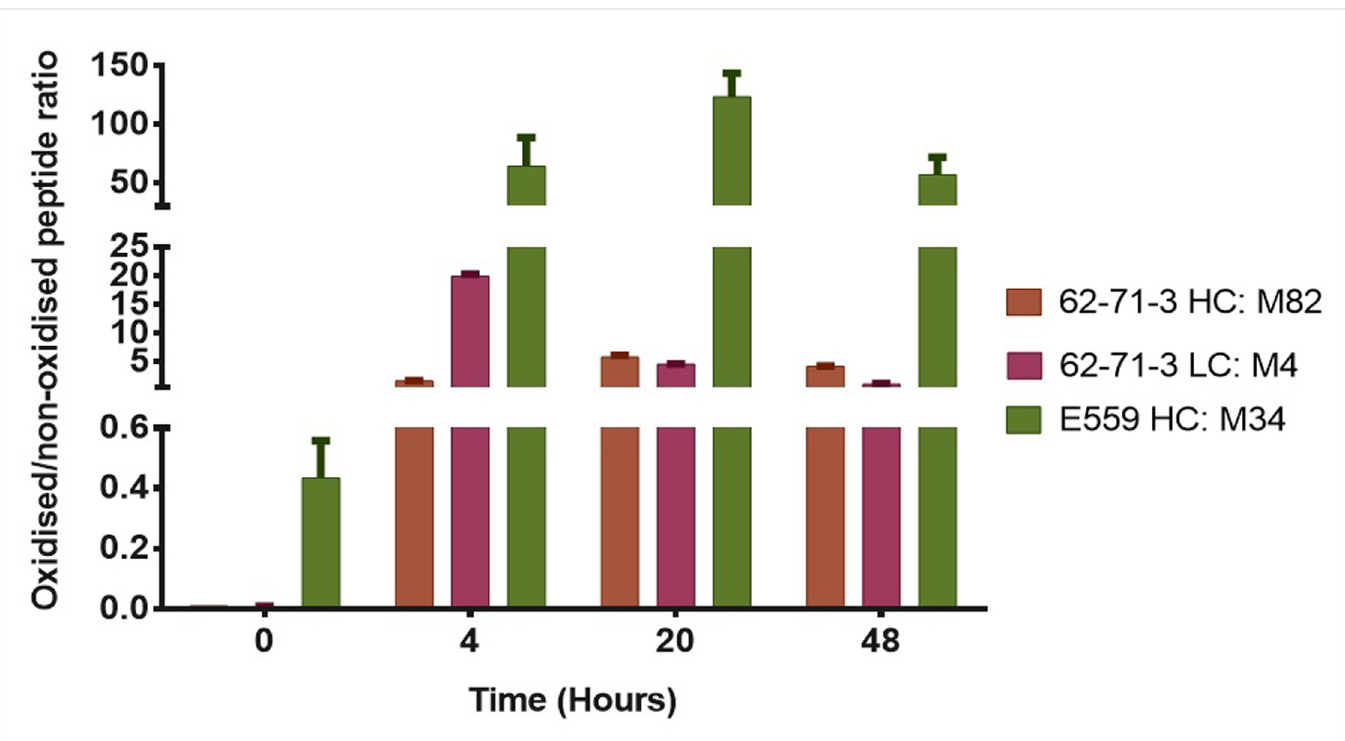
Fig 9. Oxidation levels of 62-71-3 and E559 peptides. The peak areas of oxidised peptides were divided by the peak areas of the un-modified version of the peptide, for duplicate samples incubated for 4, 20 and 48 hrs in 0.5% H 2 O 2 . The control or point 0 was a freshly thawed and digested sample and was included to identify modifications that were introduced during sample